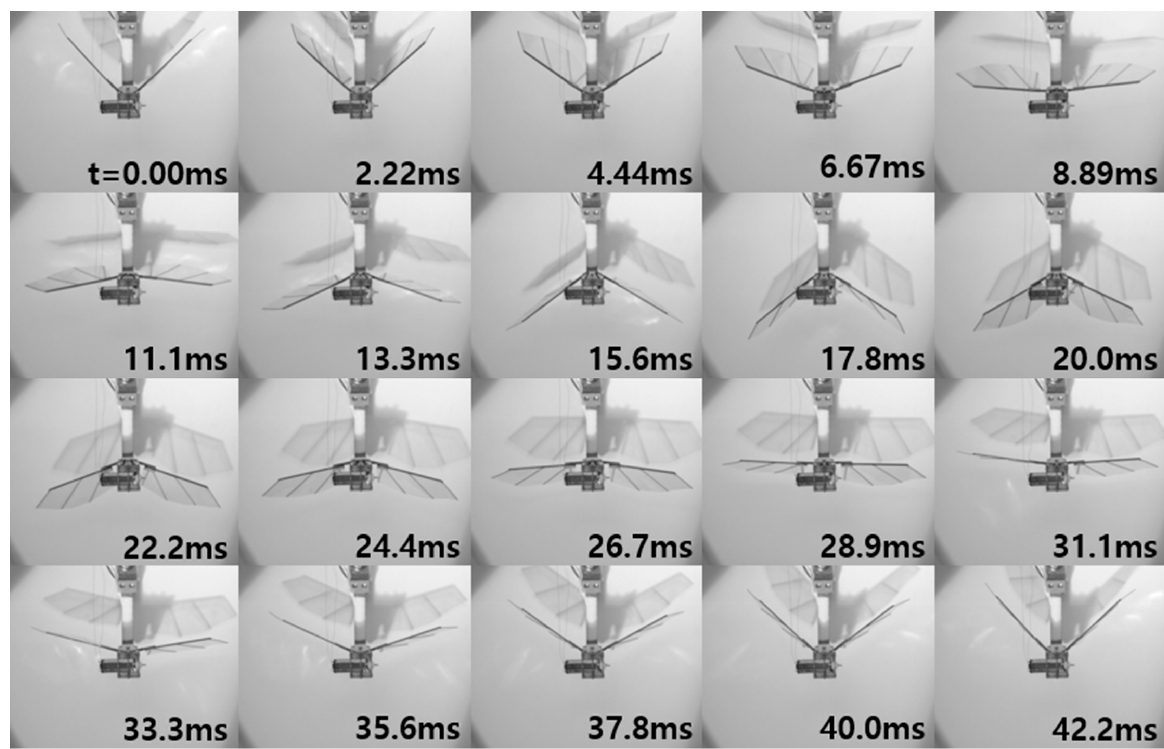
Figure 8. Snapshots while flapping at 23 Hz. A high-speed video of flapping, taken at 900 fps. Flapping angle can be measured from the top view.